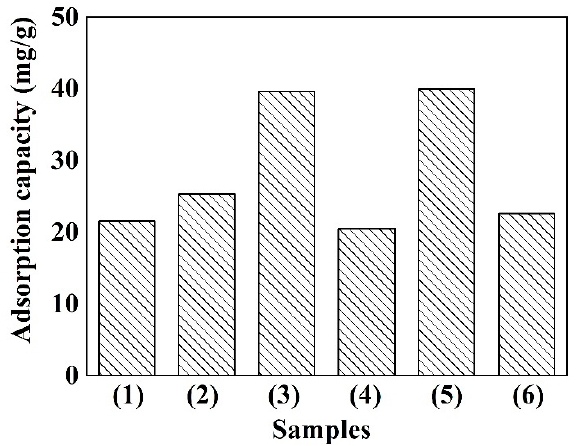
Figure 6. Cr(VI) adsorption capacity of various carbon materials. (1) T900-t30; (2) T900-t60; (3) T900- t90; (4) Cotton-based ACFs; (5) Bast-based AC; (6) AC/glass fiber